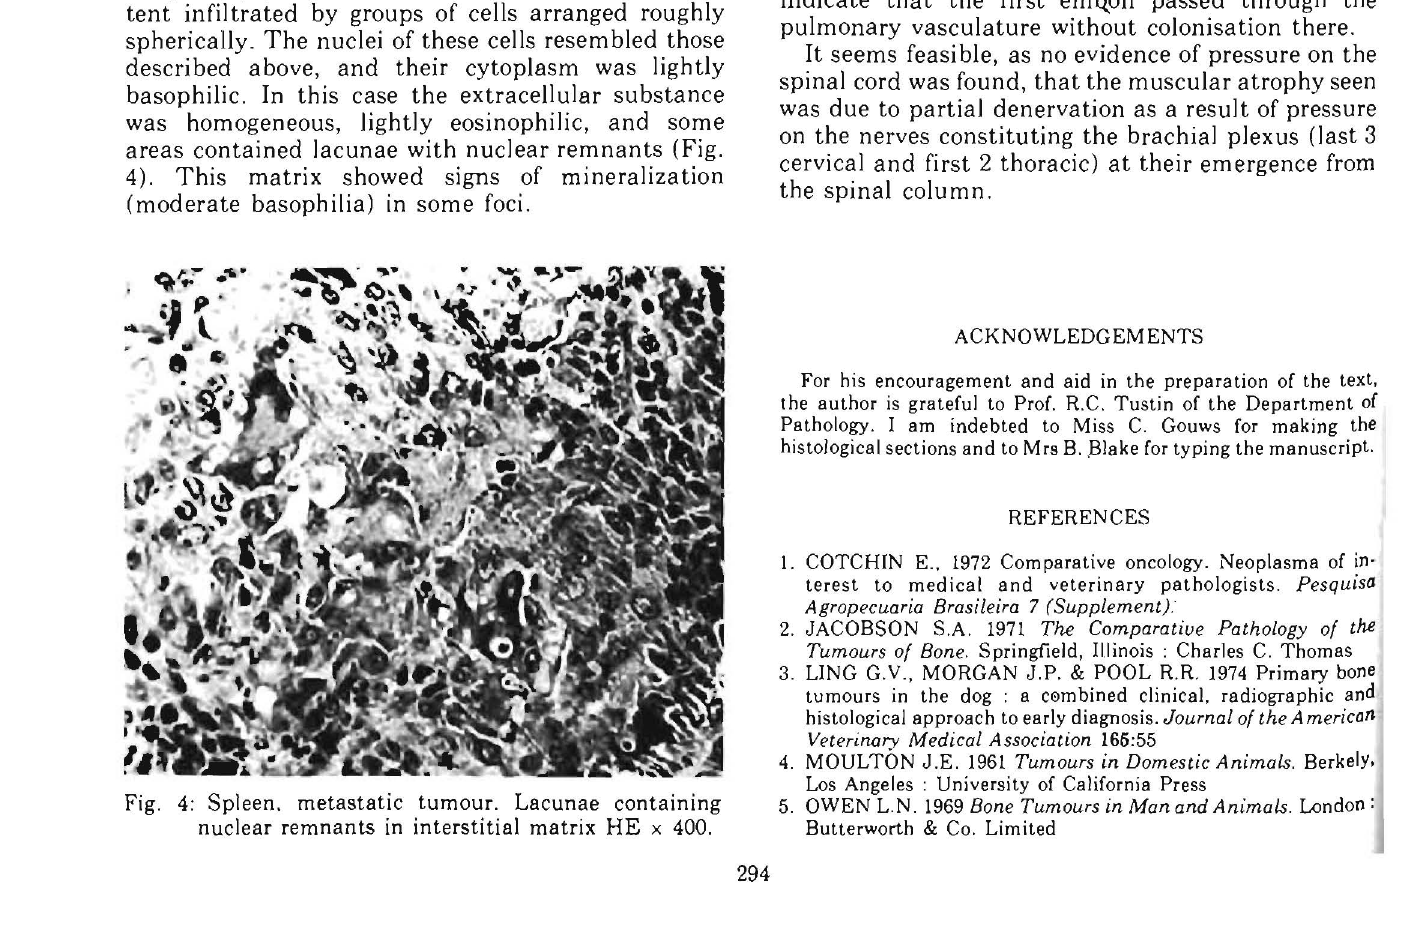
Fig. 4: Spleen. metastatic tumour. Lacunae containing nuclear remnants in interstitial matrix HE x 400.